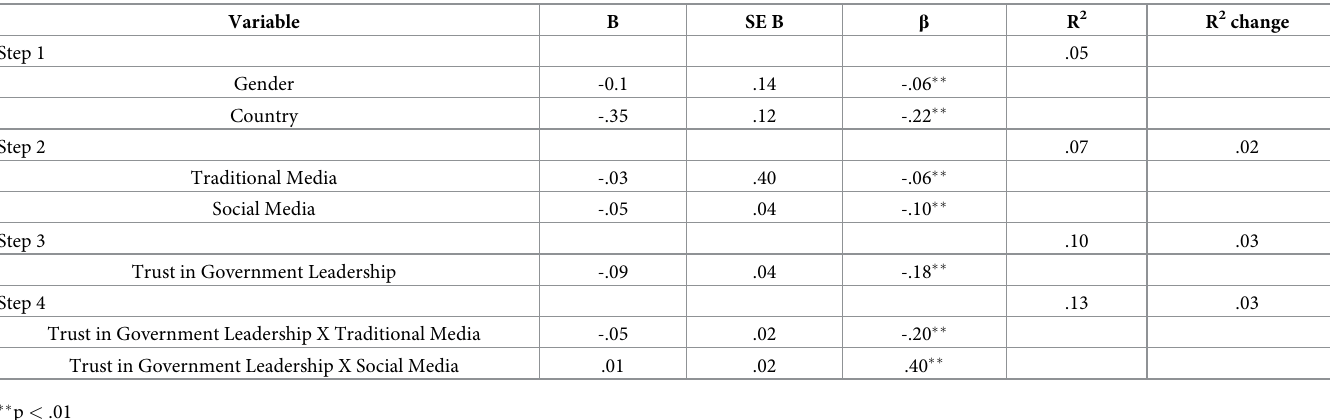
Table 3. Hierarchical linear regression of news source predicting total number of questions